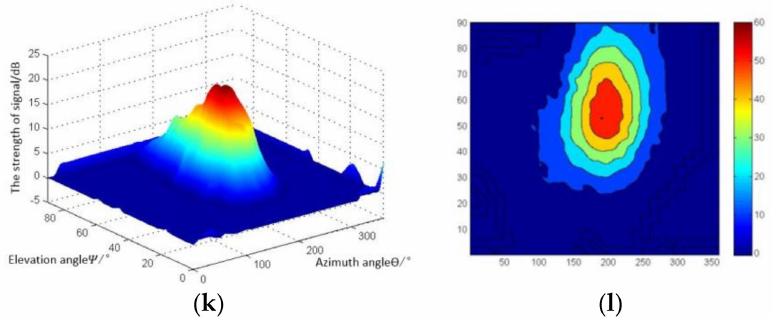
Figure 10. Contour map and DOA spectrum for test PD. ( a ) 1.5 m DOA spectrum; ( b ) 1.5 m contour map of the DOA spectrum; ( c ) 2 m DOA spectrum; ( d ) 2 m contour map of the DOA spectrum; ( e ) 2.5 m DOA spectrum; ( f ) 2.5 m contour map of the DOA spectrum; ( g ) 3 m DOA spectrum; ( h ) 3 m contour map of the DOA spectrum; ( i ) 4 m DOA spectrum; ( j ) 4 m contour map of the DOA spectrum; ( k ) 5 m DOA spectrum; ( l ) 5 m contour map of the DOA spectrum.